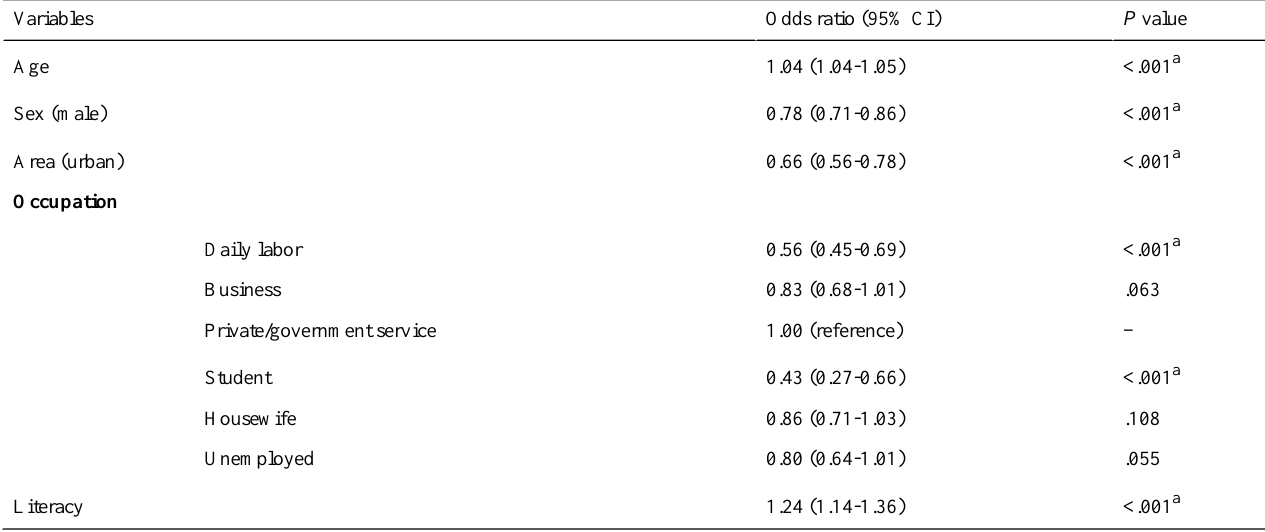
Table 3. Risk factors for NCDs associated with the overall health.